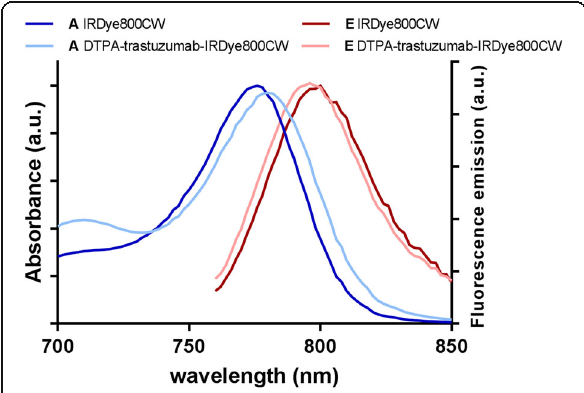
Fig. 1 Absorption (A) and fluorescence emission (E) of IRDye800CW and DTPA-trastuzumab-IRDye800CW